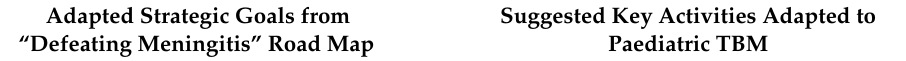
Table 5. Cont . Adapted Strategic Goals